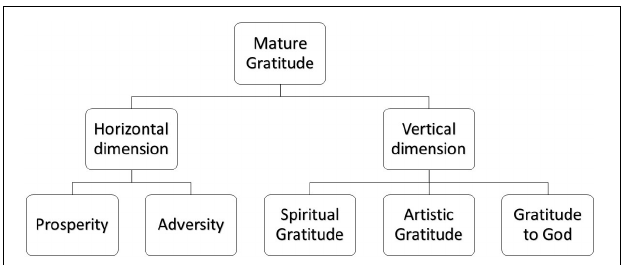
FIGURE 1 | Conceptual model of mature